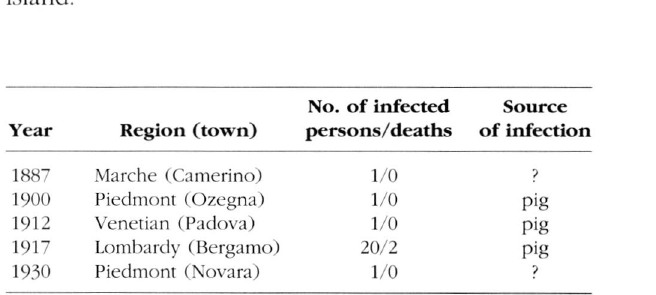
Table I. - First single human infections and the first outbreak of tri chinellosis in Italy.